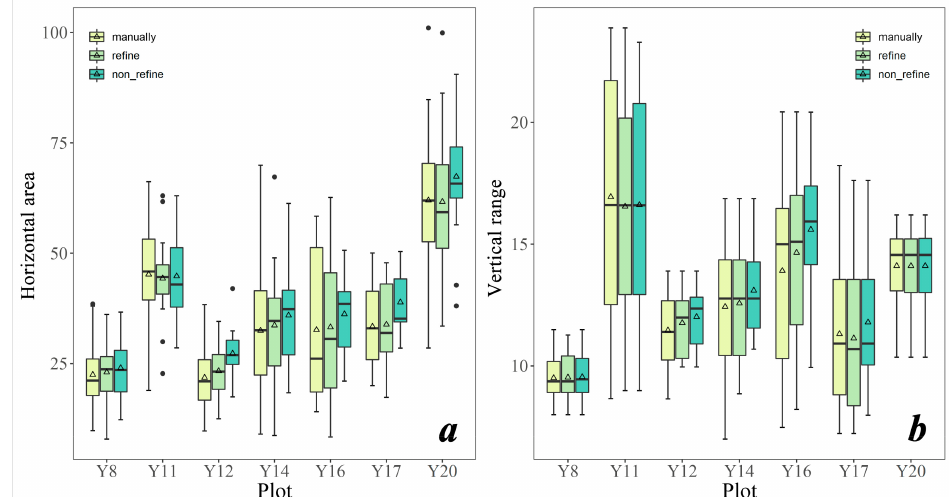
Figure 10. Boxplot of two indicators (horizontal area ( a ) and vertical range ( b ) of segmented individ- ual trees) of the three methods (manually, segmentation with the refining process, and segmentation without the refining